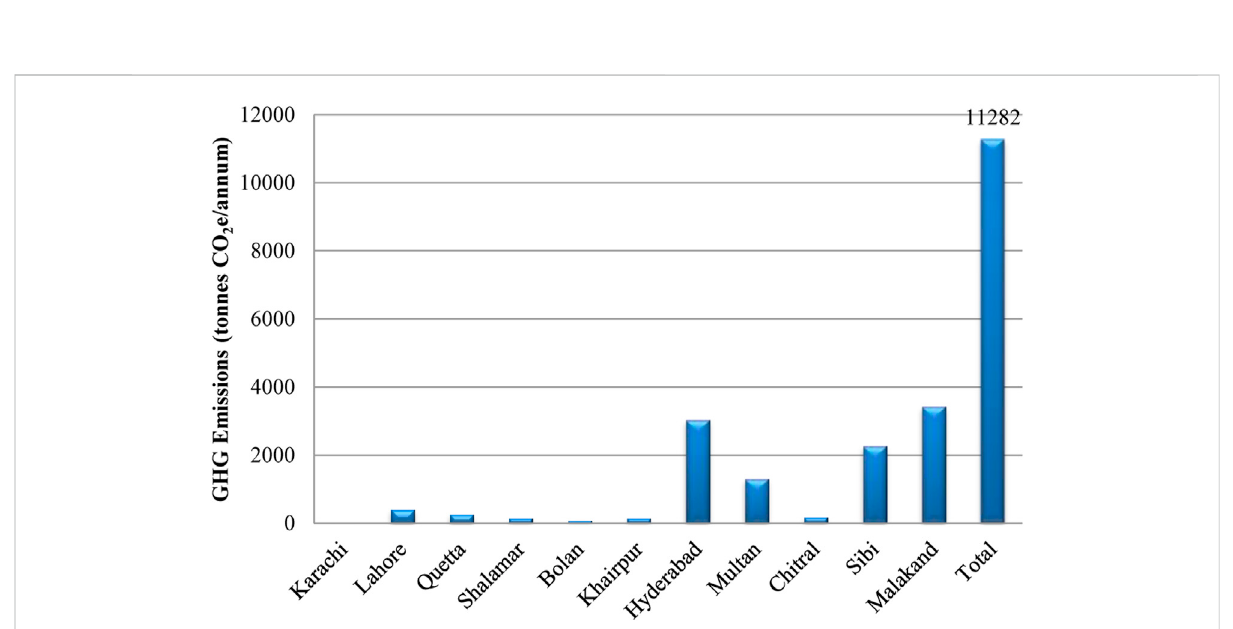
FIGURE 5 Total annual GHG emissions (CO 2 e) from PNSC fl eet based on fuel consumption